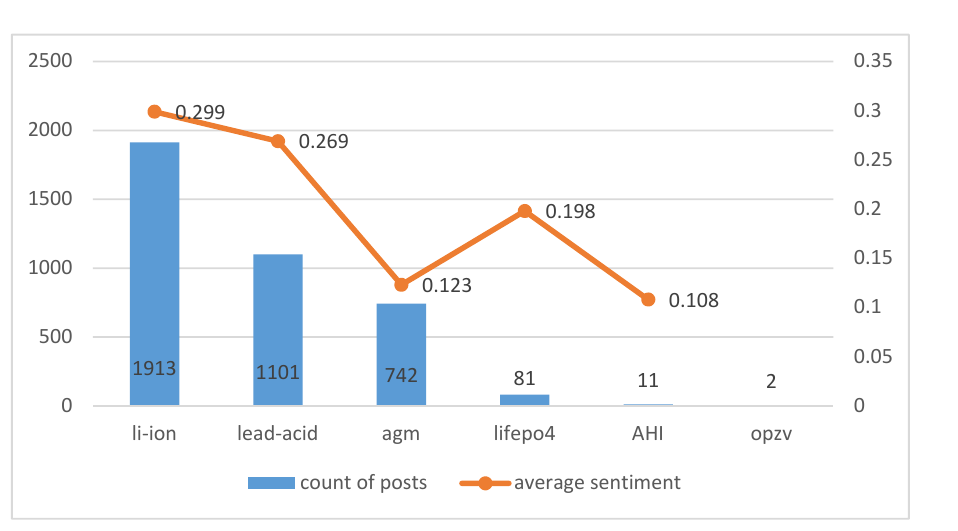
Figure 9. Number of mentions of the trending battery technologies and their sentiment scores.